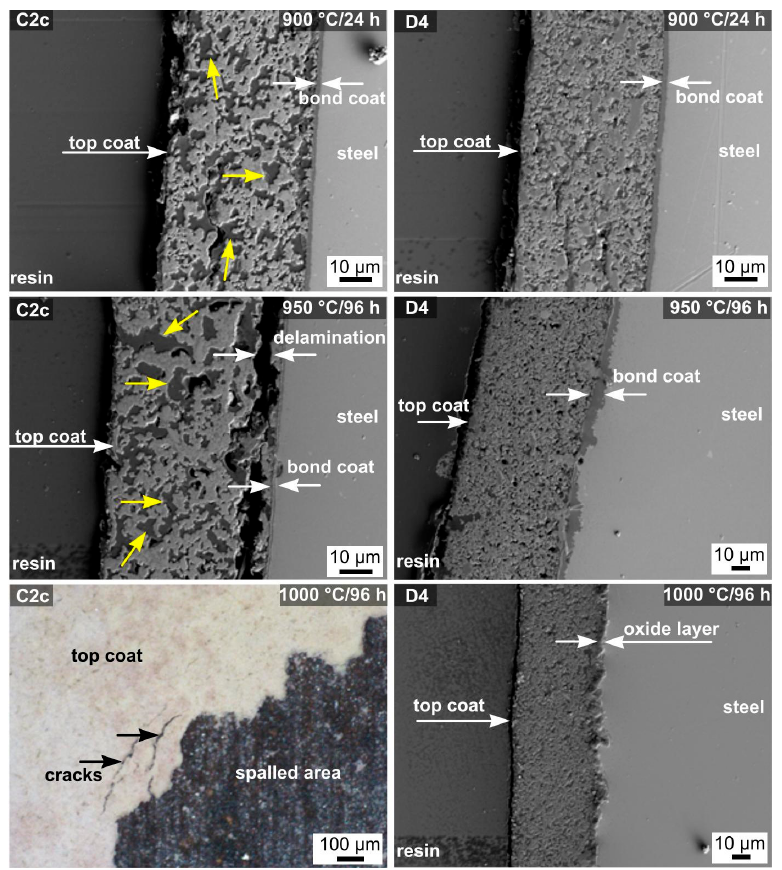
Figure 7. SEM cross-sections of C2c and D4 compositions after oxidation tests in a synthetic air atmosphere at different temperature and times. The yellow arrows show the pores filled with synthetic resin.